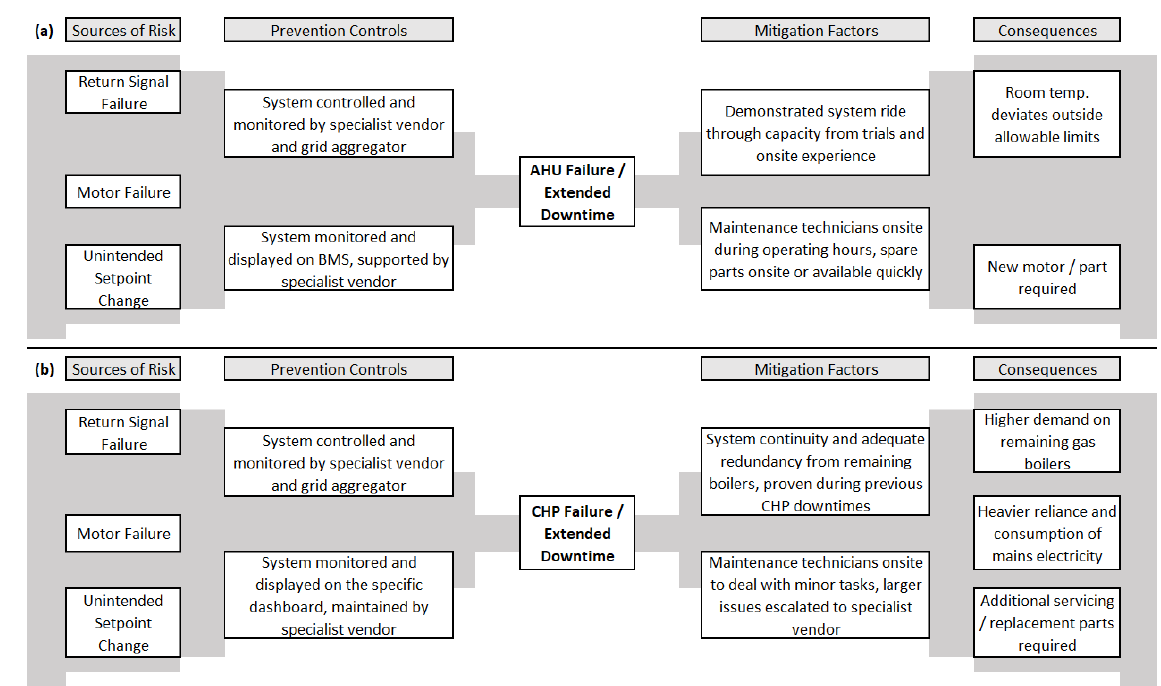
Figure 4. Bow tie analysis of ( a ) an AHU failure or extended downtime and ( b ) a CHP unit failure or extended downtime, illustrating the sources of risk, prevention controls, mitigation factors and potential consequences.